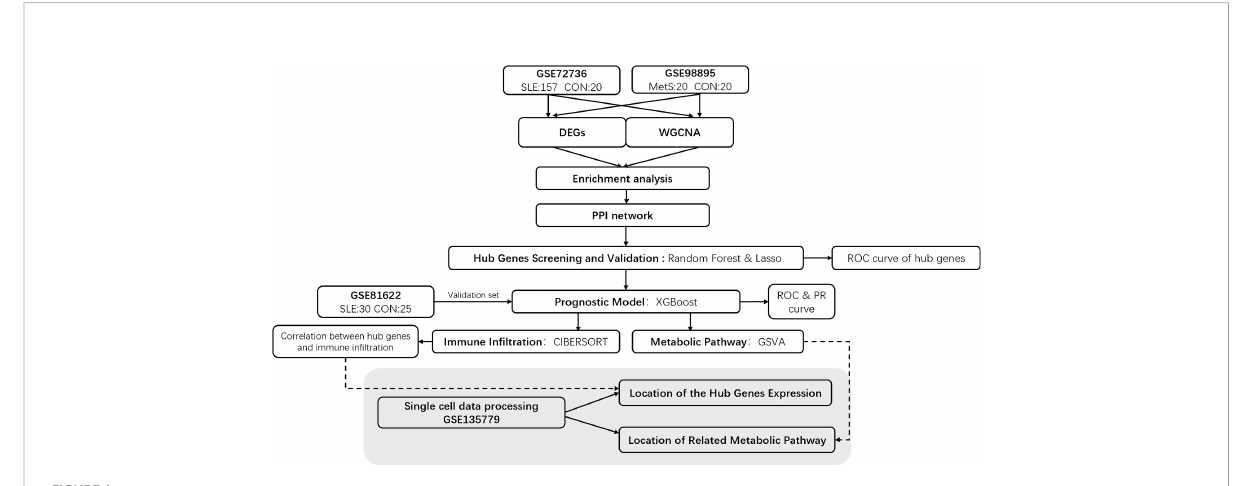
FIGURE 1 Flowchart of